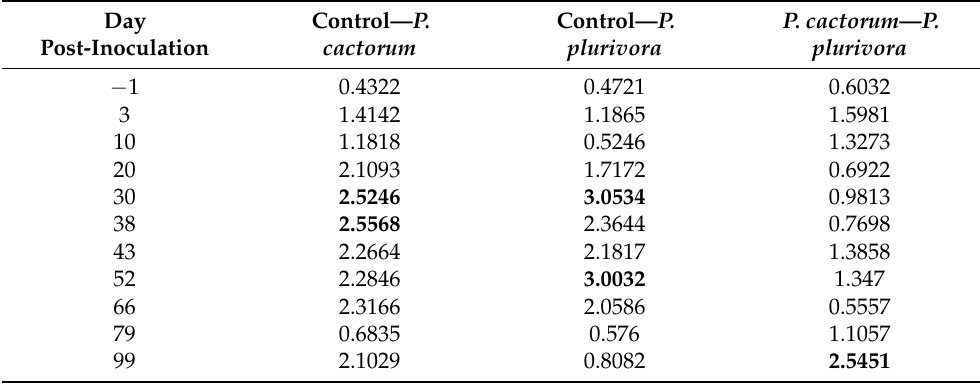
Table 1. The Euclidean distances showing differences among the examined treatments during the course of gas exchange and chlorophyll a measurements. Numbers given in bold indicate days post-inoculation in which the treatments were the most